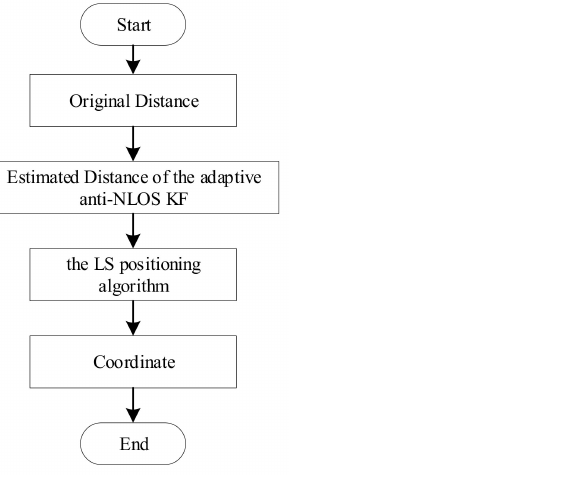
Figure 4. Flow chart of the adaptive anti-NLOS KF positioning